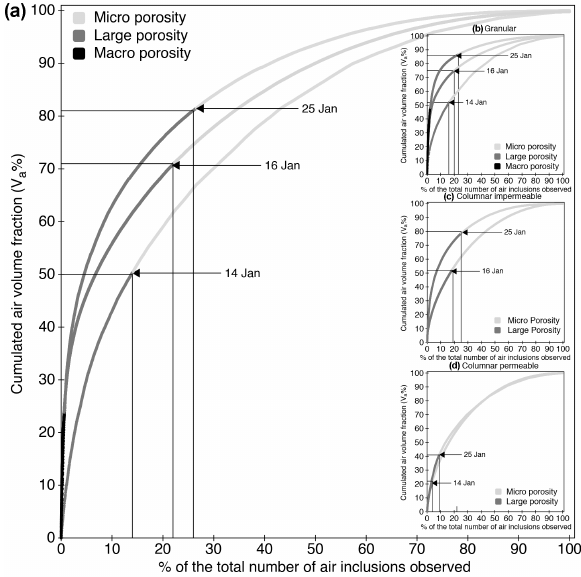
Figure 11. The cumulated contribution of the macro, large and mi- cro bubbles to the cumulated relative air volume fraction for the whole ice core (a) , and in granular (b) , columnar impermeable (c) and columnar permeable ice (d) . It shows that, a smaller number of large bubbles (e.g., Large on 25 January) produced most of the air volume fraction (i.e porosity), and this is true for both the whole ice core (a) and for each type of ice (b, c, d)